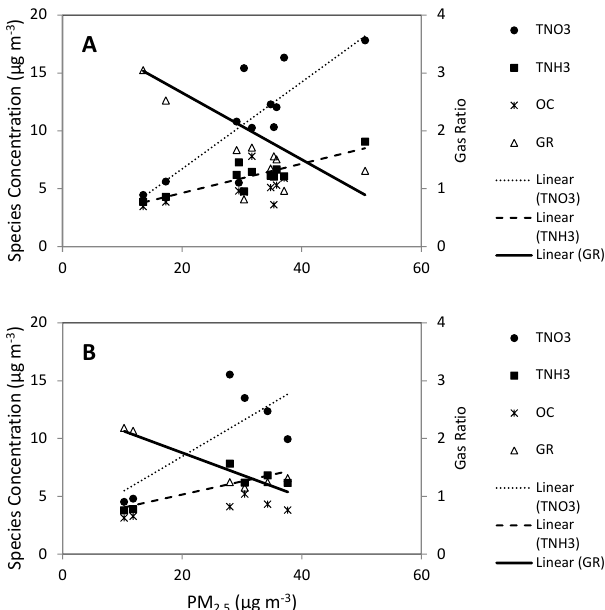
Fig. 10. Total nitrate, total ammonia, OC, and gas ratio as a function of PM 2 . 5 for various periods in the Milwaukee (A) and Figure 10. Total nitrate, total ammonia, OC, and gas ratio as a function of PM 2.5 for various 1015 Mayville (B) datasets. Lines represent linear regression of data- periods in the Milwaukee (A) and Mayville (B) datasets. Lines represent linear regression of 1016 points. For Milwaukee, the linear regression equation for TNO 3 datapoints. For Milwaukee, the linear regression equation for TNO 3 is -0.8 + PM 2.5 x 0.37 and 1017 is − 0.8 + PM 2 . 5 × 0.37 and for TNH 3 it is 2.1 + PM 2 . 5 × 0.13. for TNH 3 it is 2.1 + PM 2.5 x 0.13. For Mayville, the linear regression equation for TNO 3 is 2.4 + 1018 For Mayville, the linear regression equation for TNO 3 is PM 2.5 x 0.30 and for TNH 3 it is 2.9 + PM 2.5 x 0.11. One Milwaukee datapoint for gas ratio is not 1019 2.4 + PM 2 . 5 × 0.30 and for TNH 3 it is 2.9 + PM 2 . 5 × 0.11. One Milwaukee datapoint for gas ratio is not plotted but does influence plotted but does influence the regression (the Mar I episode with a gas ratio of 5.6). 1020 the regression (the Mar I episode with a gas ratio of